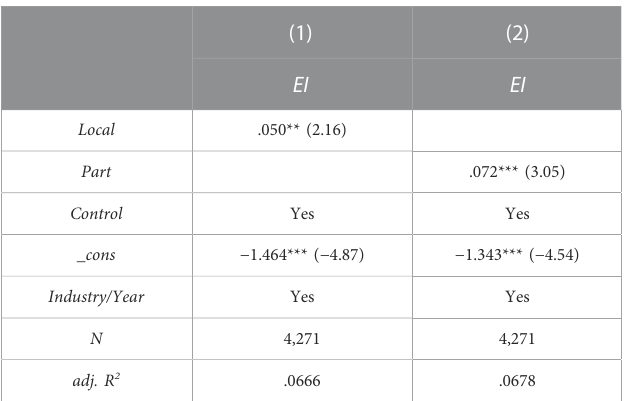
TABLE 10 Results of further